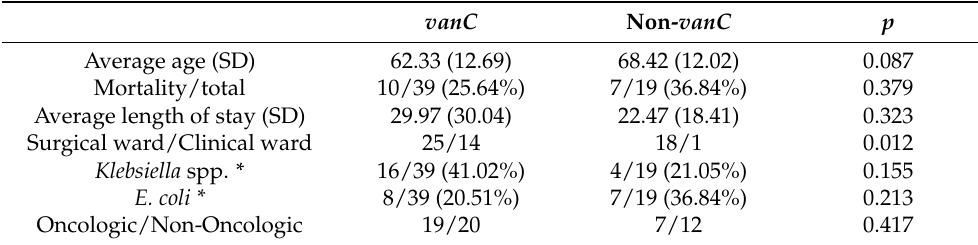
Table 5. Comparison of vanC enterococci with non- vanC enterococci